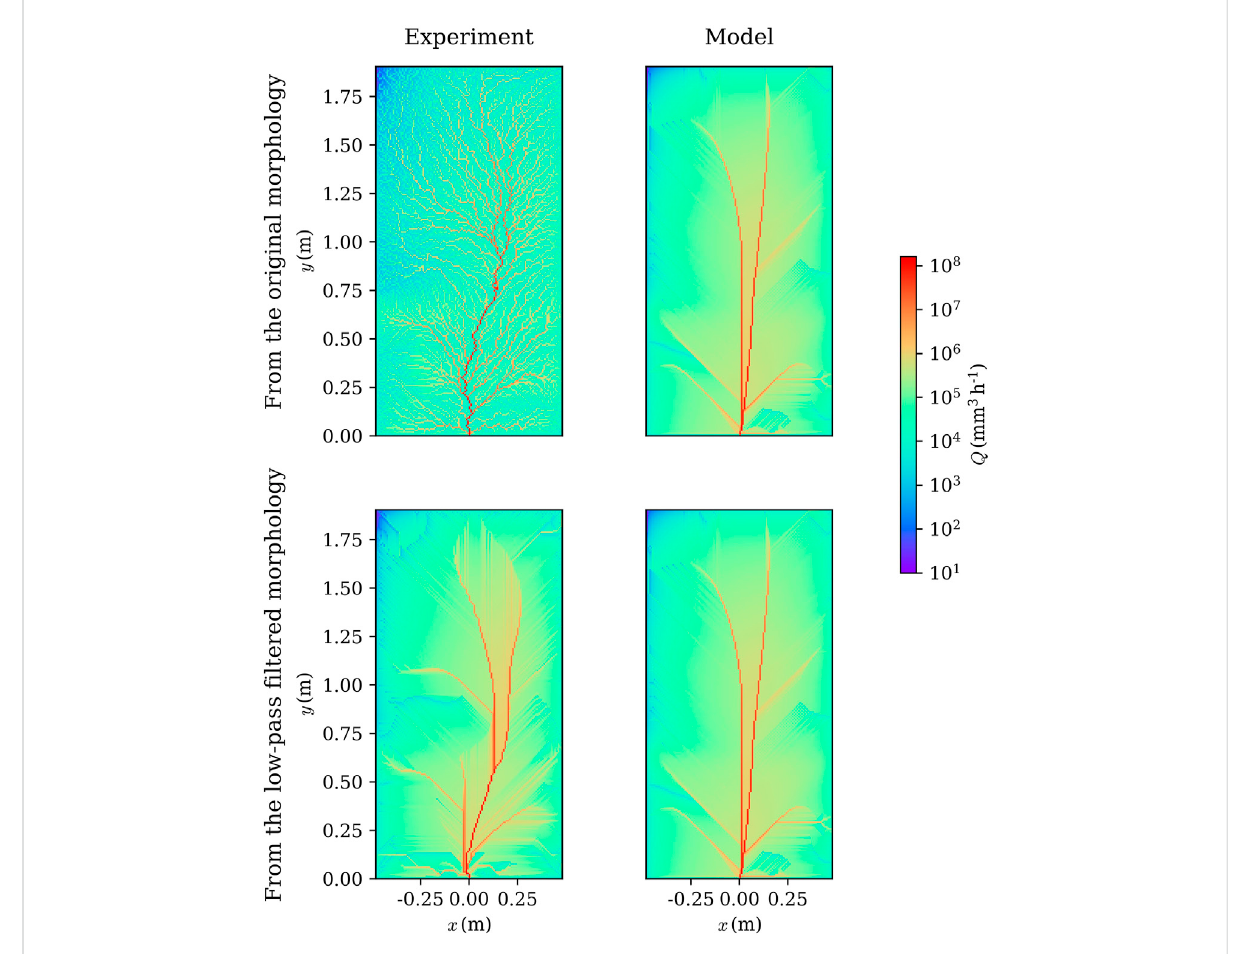
FIGURE 8 The original discharge network and the network extracted from the low-pass fi ltered morphology at t = 8